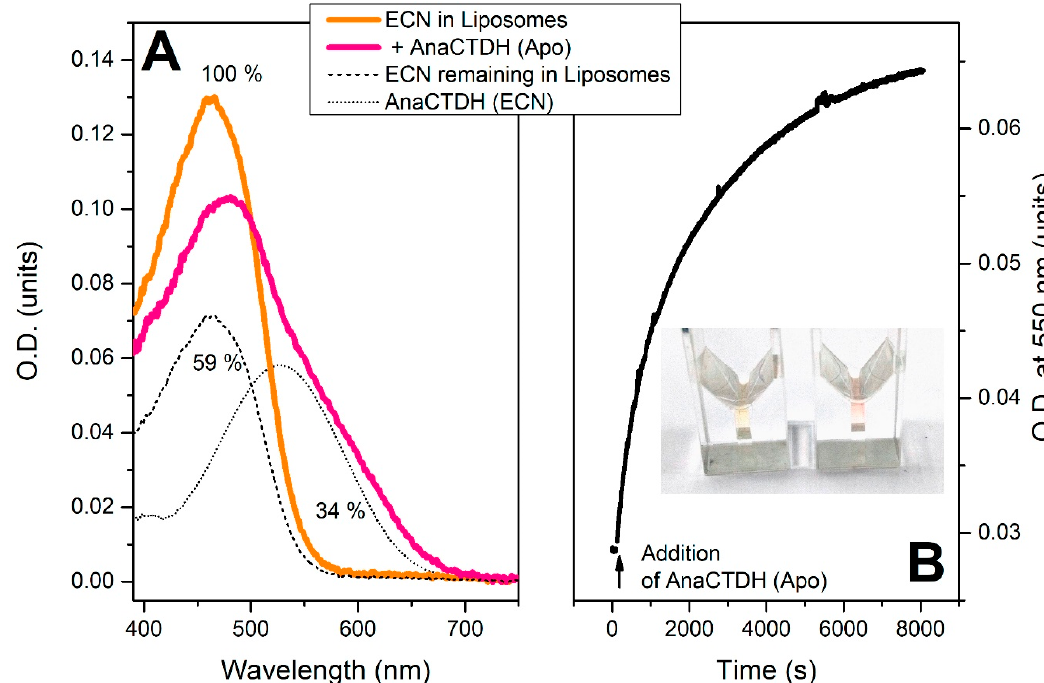
Figure A3. ECN uptake from liposomes by AnaCTDH apoprotein. ( A ) Absorption spectra of ECN in liposomes before (orange) and after (pink) four hours of incubation with 300 μ M of AnaCTDH at 30 °C. Resulting spectrum (pink) was decomposed into components which correspond to absorption of ECN remaining in liposomes (dashed line) and in AnaCTDH (dotted line). Percentiles indicate the ECN content in different fractions comparing to the indicial concentration in liposomes. Some fraction of carotenoid (~7%) was lost due to photodegradation upon the continuous absorption measurements. ( B ) Time-course of accumulation of AnaCTDH(ECN) due to carotenoid uptake from liposomes monitored as increase of optical density at 550 nm. The inset shows cuvettes with solutions of ECN- containing liposomes before (left) and after incubation with AnaCTDH apoprotein.